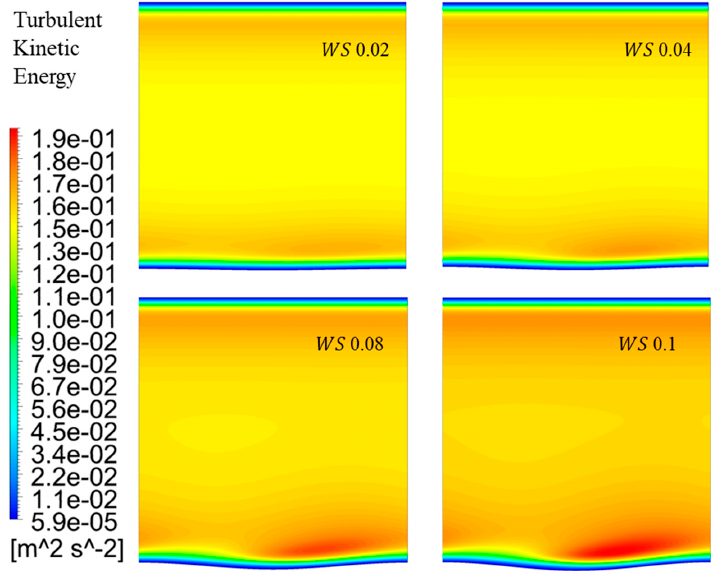
Figure 17. TKE contours with respect to 𝑊𝑆 -variation.